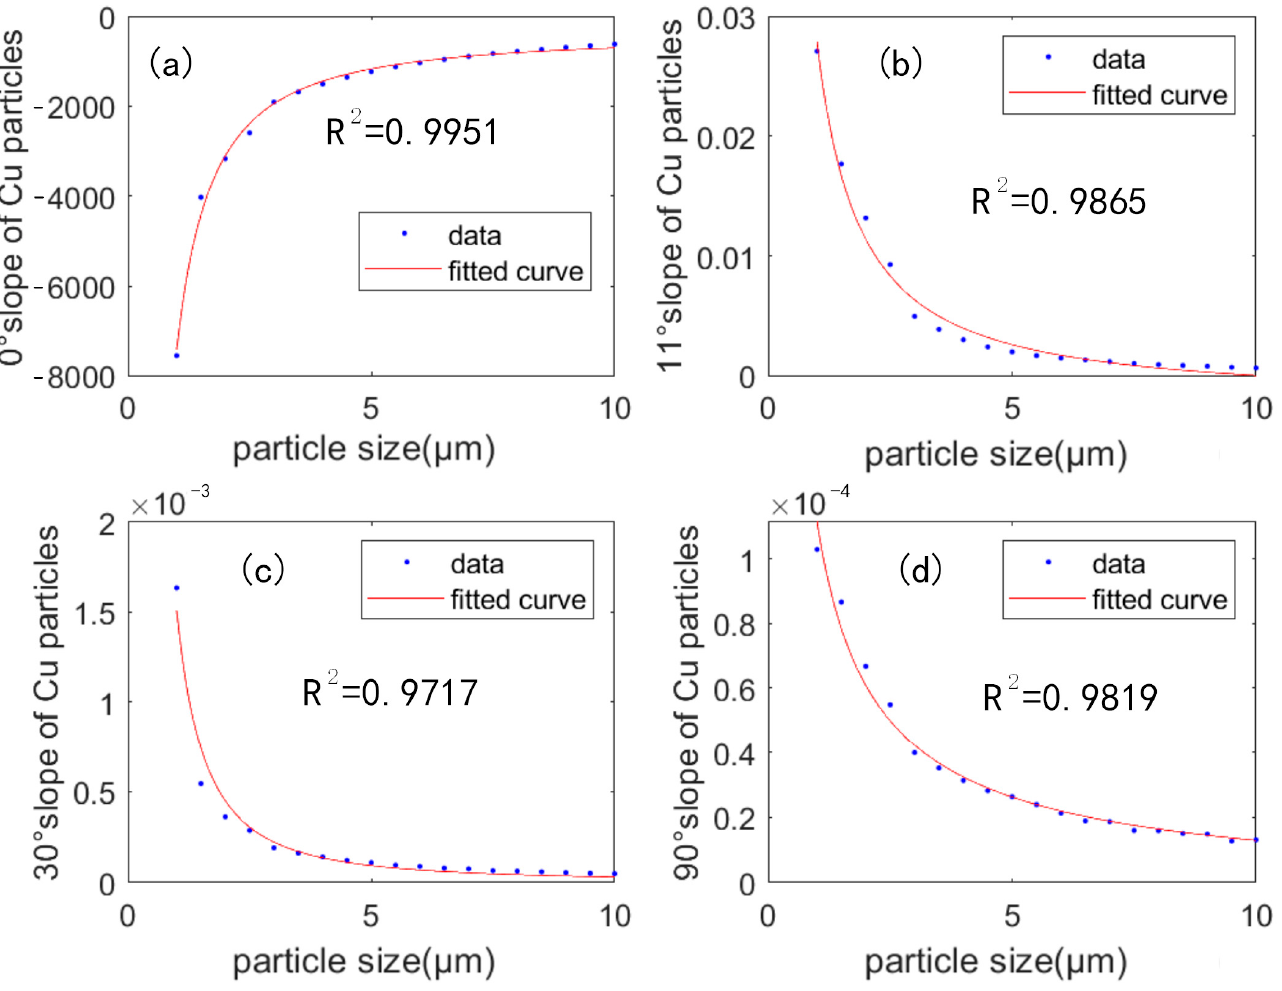
Figure 8. The relationship between the slope and the copper particles size at angle ( a ) 0° ( b ) 11° ( c ) 30° ( d ) 90°. ( c ) 30 ◦ ( d ) 90 ◦